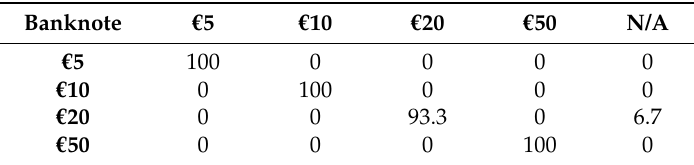
Table 3. Euro banknote value recognition for a distance of 45 cm between the system and banknote in lighted indoor conditions, %.